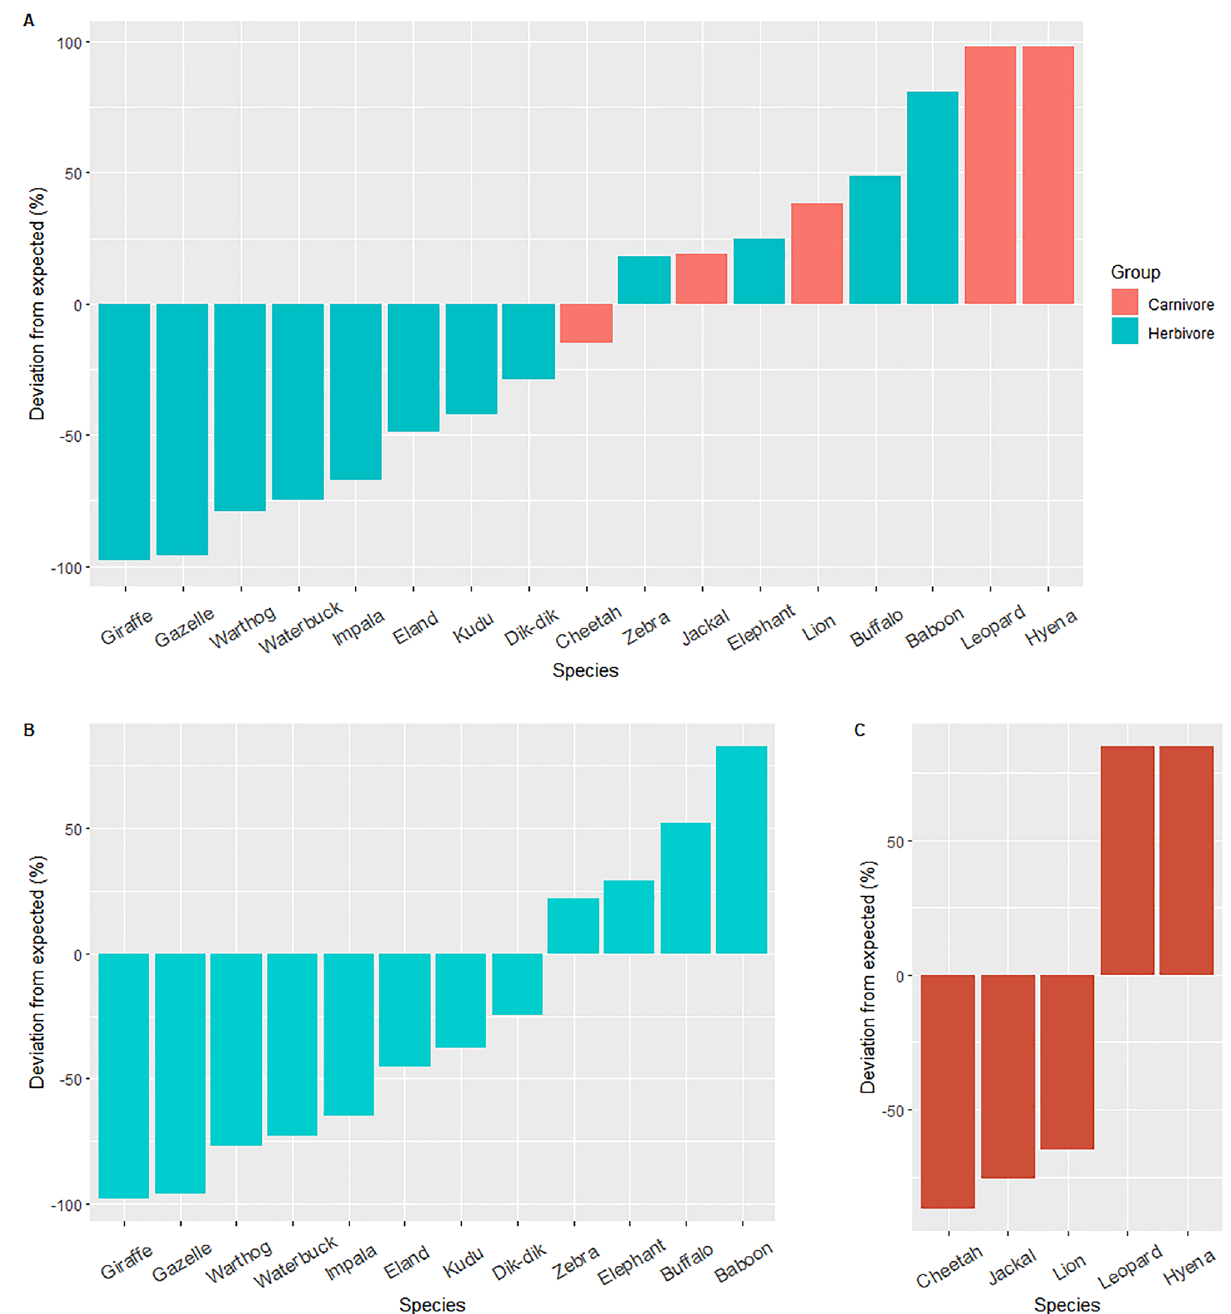
Figure 3. The percent deviation of SGR underpass utilization by medium- to large-sized mammals when herbivores and carnivores are simultaneously considered ( A ) and when herbivores ( B ) and carnivores ( C ) are independently considered. The expected frequency was calculated based on the frequency of their sighting on TCA